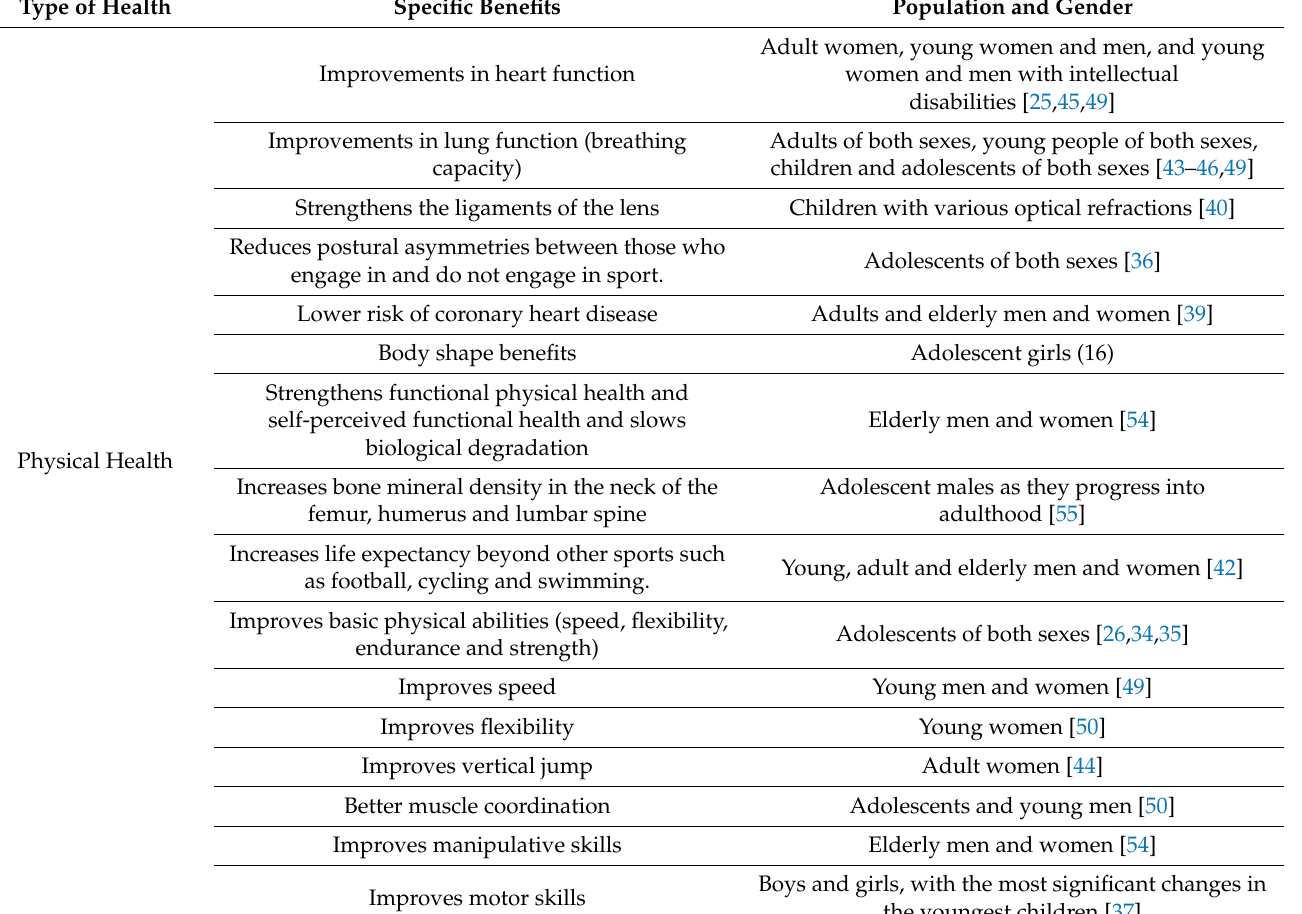
Table 5. Benefits produced by badminton engagement in different populations and